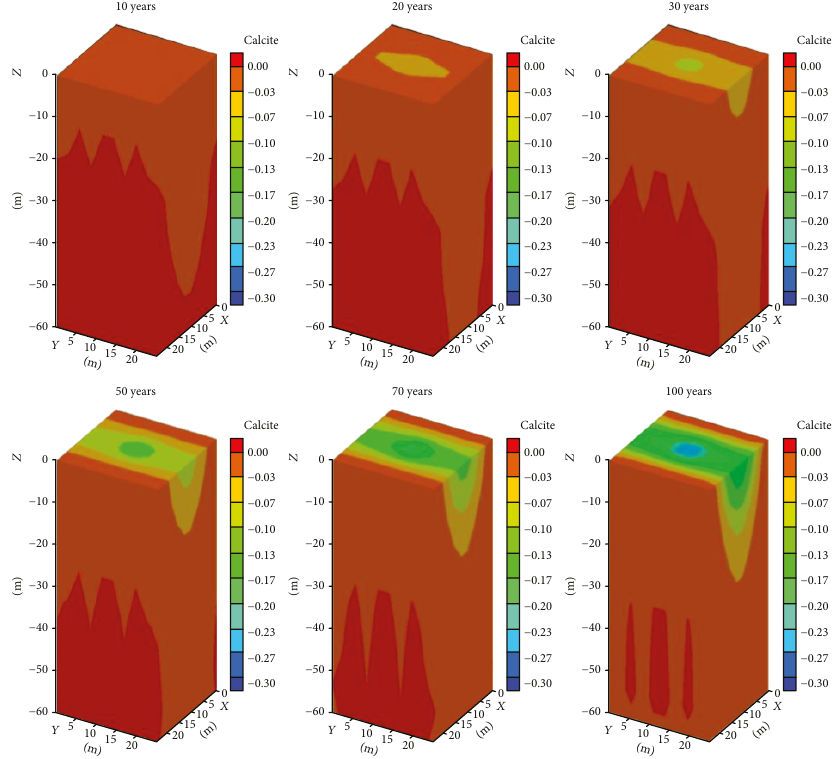
Figure 13: The corrosion range of the fi ssure under weak hydrodynamic conditions-medium permeability — 20 ° C.